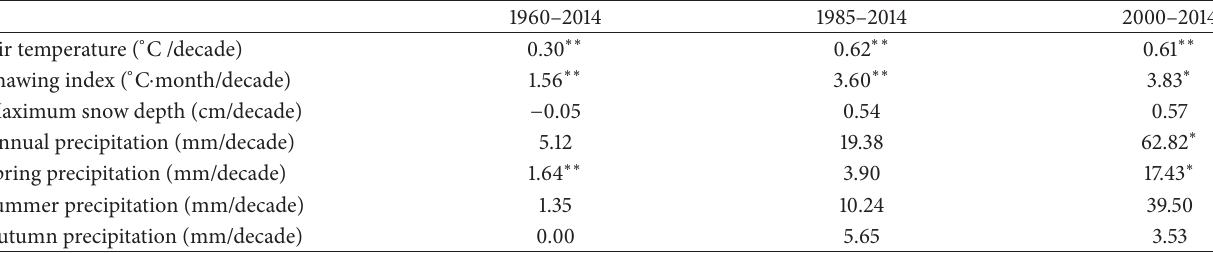
Table 4: The annual trends in air temperature, thawing index, maximum snow depth, annual precipitation, spring precipitation, summer precipitation, and autumn precipitation for three different time periods on the TRSR. Significance levels: ∗ 𝛼 = 0.05 ; ∗∗ 𝛼 = 0.01 .